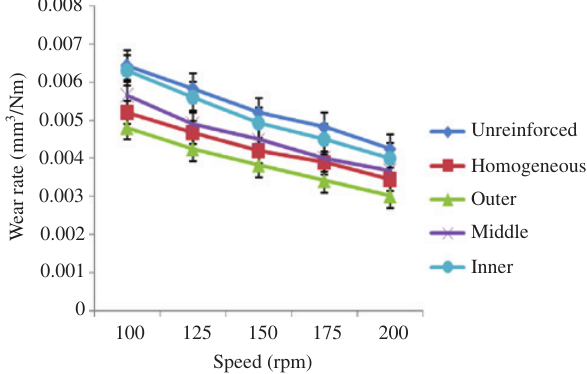
Figure 10: Effect of speed on the alloy and composite surfaces at a constant load of 57